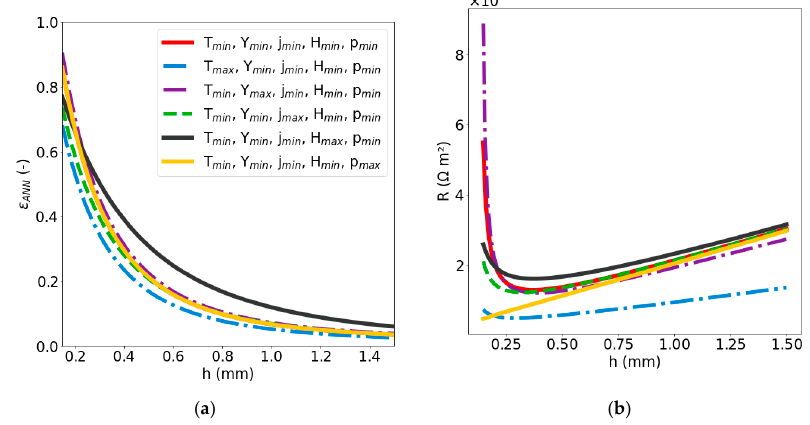
Figure 5. Void fraction ε ANN ( a ) and ohmic resistance R ( b ) depending on the electrolyte thickness h in [0.3;1.5] mm.